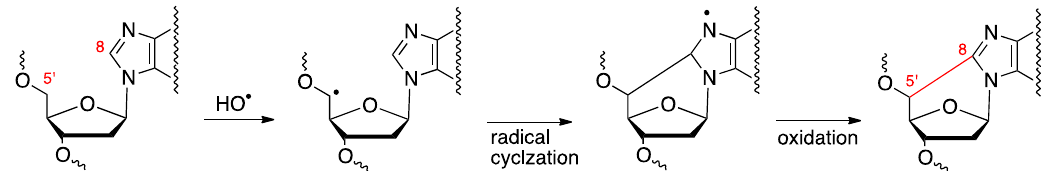
Figure 1. Purine 2 ′ -deoxynucleotide reacts with a hydroxyl radical (HO • ), yielding the purine 5 ′ ,8-